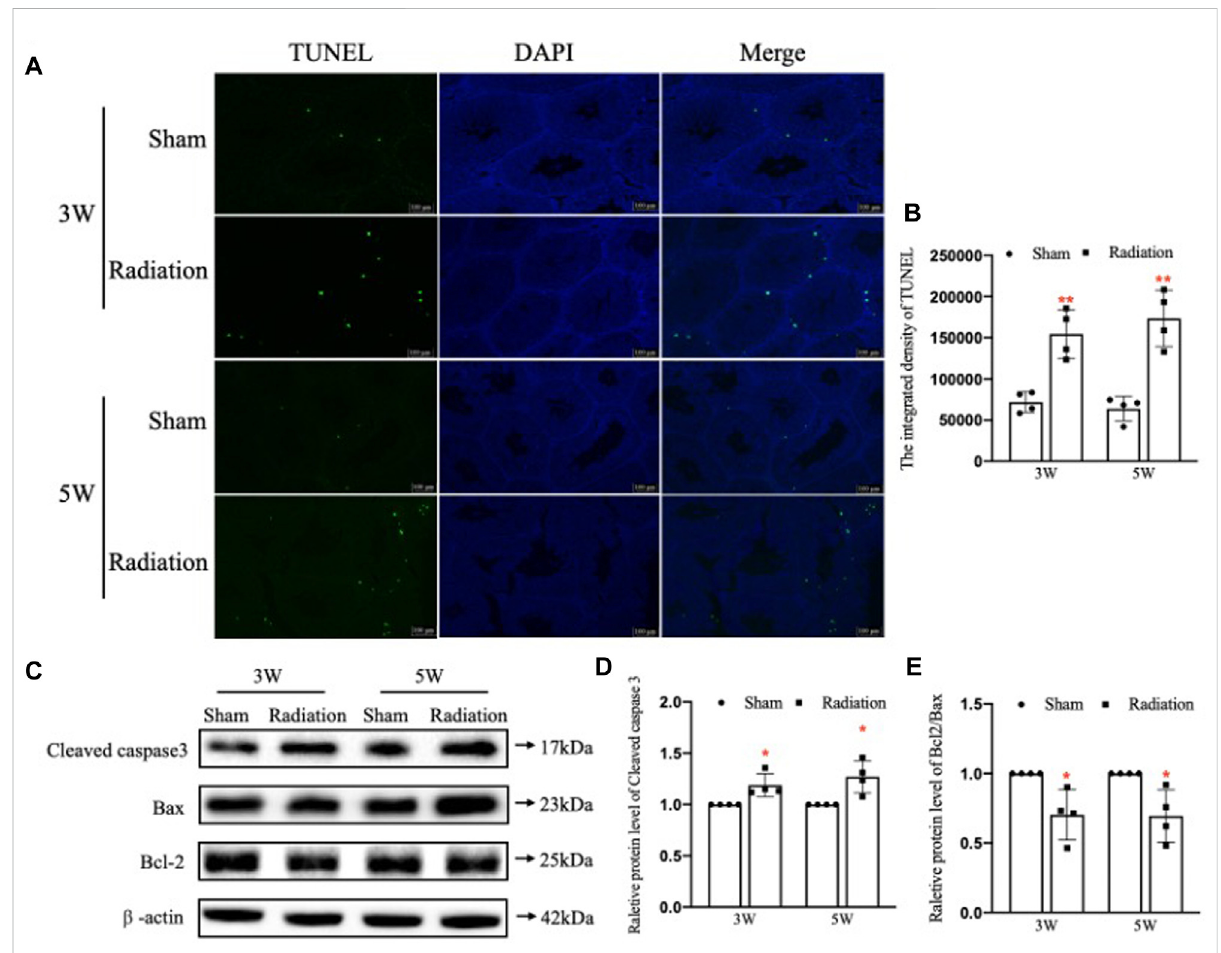
FIGURE 3 AbscopaleffectsofthoracicX-rayirradiationontesticularcellapoptosisinmice. (A,B) TUNELstainingandaverage fl